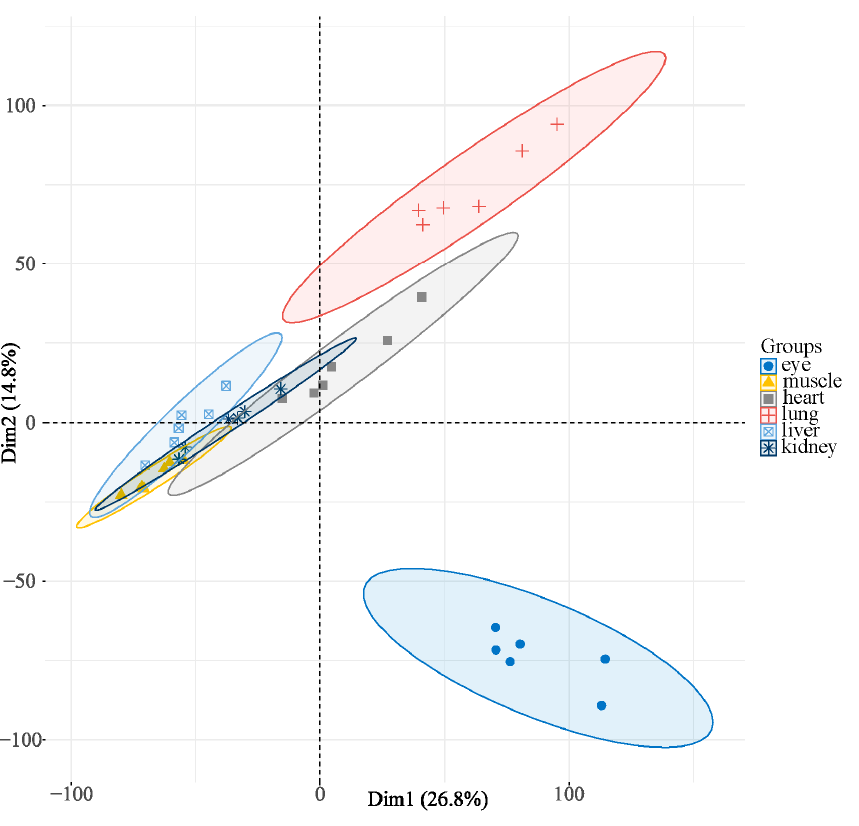
Figure 3. PCA plot of 36 samples from two snakes.